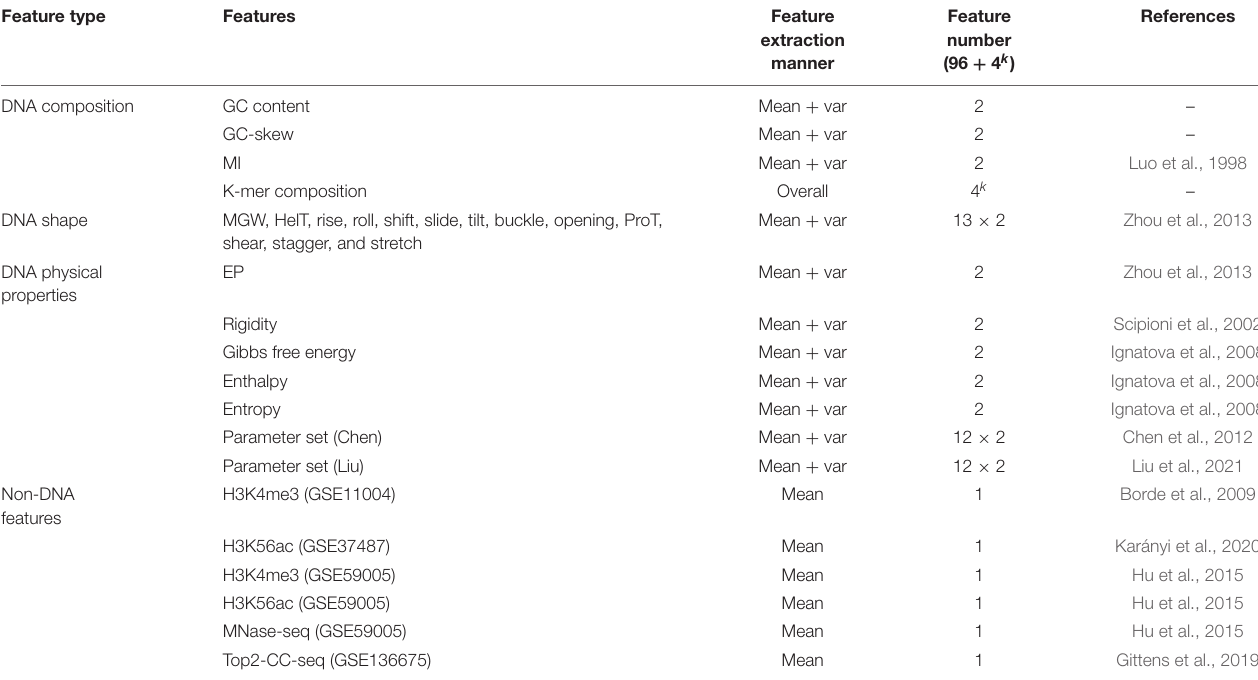
TABLE 1 | Features used in this